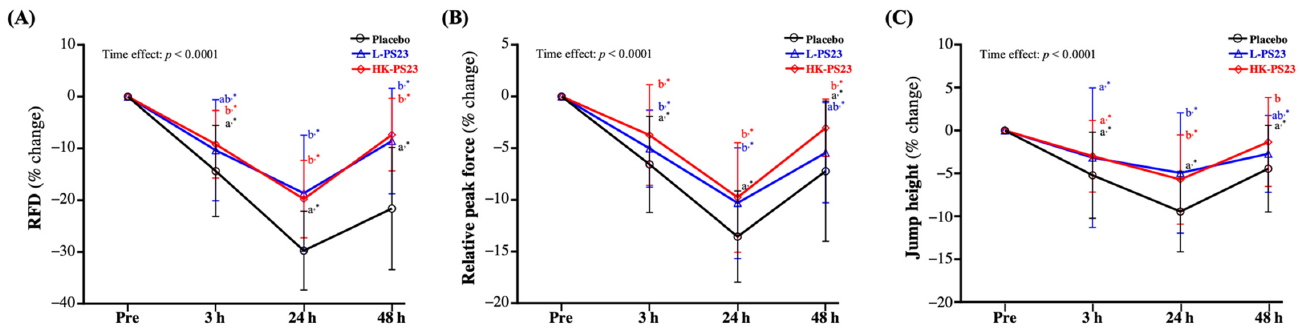
Figure 2. Effects of 6 weeks of L-PS23 and HK-PS23 supplementation on percentage change in CMJ test ( A ) RFD, ( B ) relative peak force, and ( C ) jump height. Data are expressed as mean ± SD for n =35 subjects per group. Different superscript letters (a, b) indicate significant difference between groups at the same time point ( p < 0.05). * indicates that each group is significantly different from pre-EIMD at different time points ( p < 0.05). RFD, rate of force